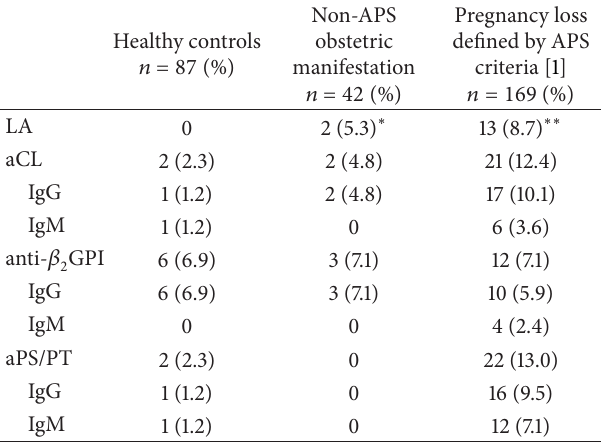
Table 3: Prevalence of aPL in patients with obstetric complications and healthy controls.